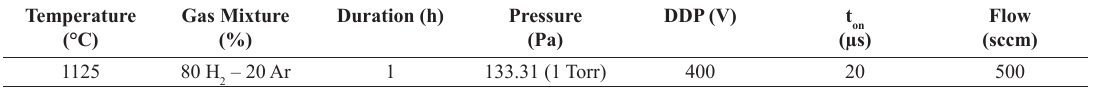
Table 1. Sintering parameters of the samples.